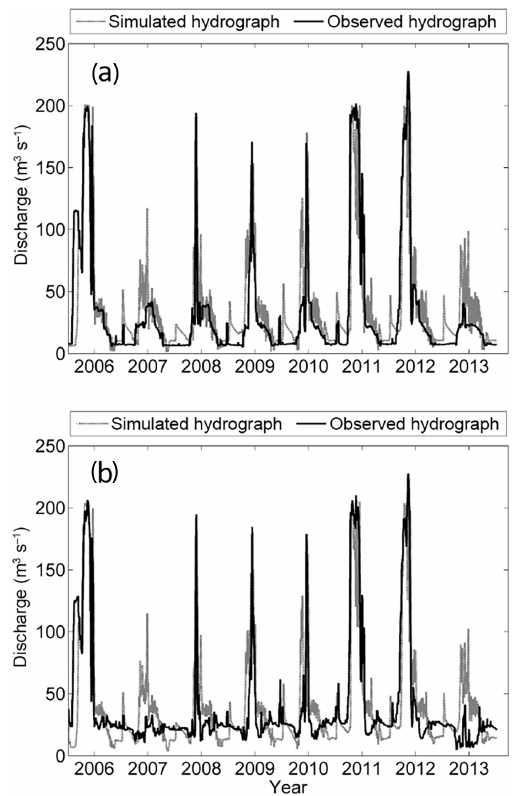
Figure 4. Simulated discharge and the observations during the cal- ibration (2006–2009) and validation (2010–2013) periods at the Glenwood station of the Boise River (a) and Parma station of the Boise River (b) .